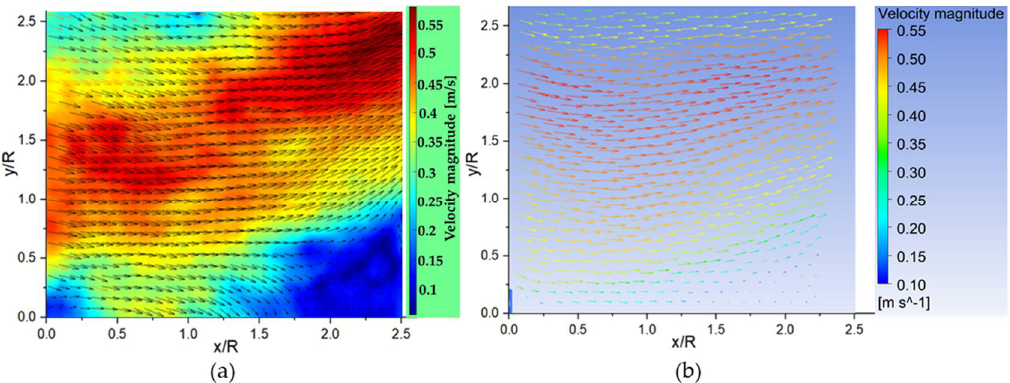
Figure 10. Velocity magnitude color maps: ( a ) PIV and ( b ) CFD simulation.